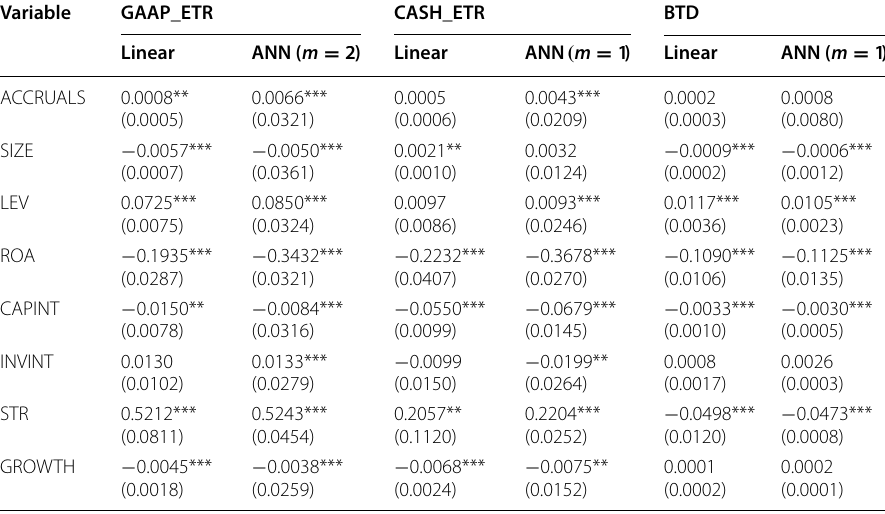
Table 6 Marginal effect (mean derivative, ˆ D k ) estimates and significance testing results. Linear versus optimal cross‑validated ANN